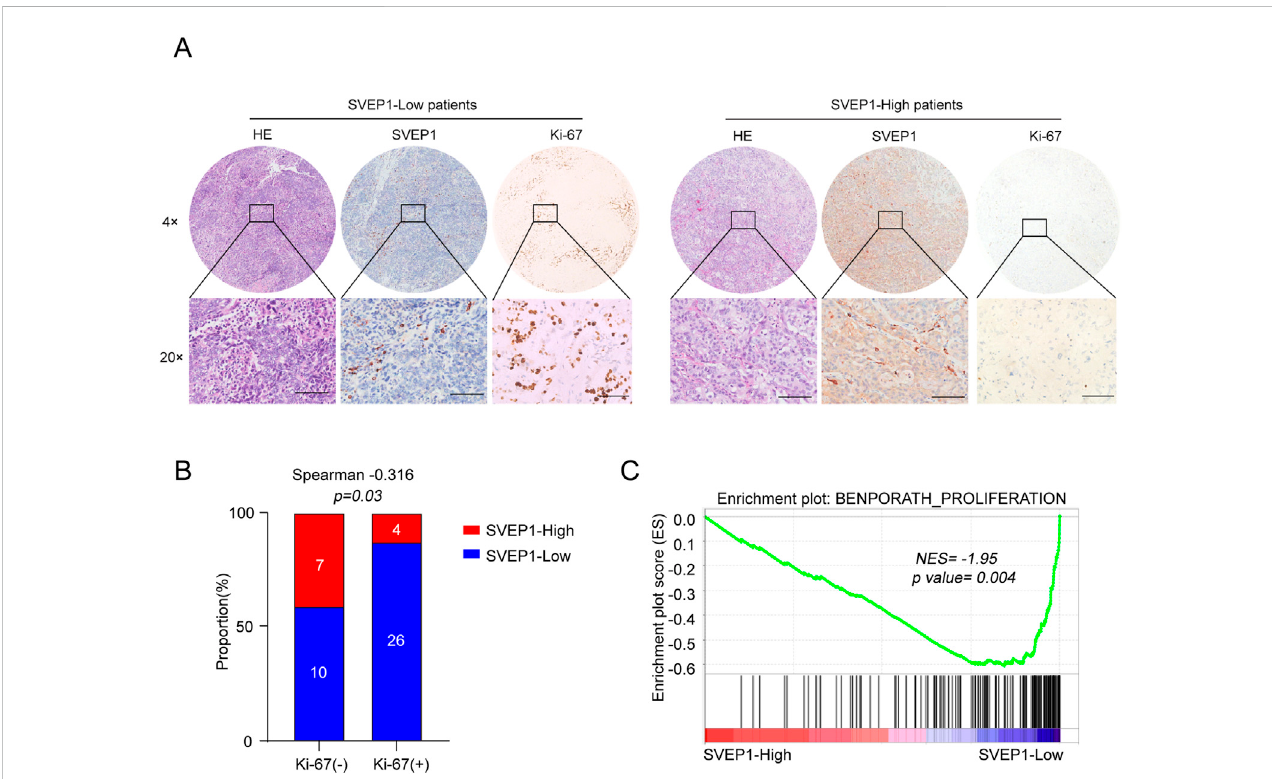
FIGURE 4 ICC samples with low expression of SVEP1 present malignant proliferation phenotype. (A) Representative HE and IHC images of SVEP1 and Ki-67 in ICC tissues. (B) Correlation analysis of Ki-67 expression with the SVEP1 level in ICC samples. (C) GSEA of correlation between the expression of SVEP1 and tumor